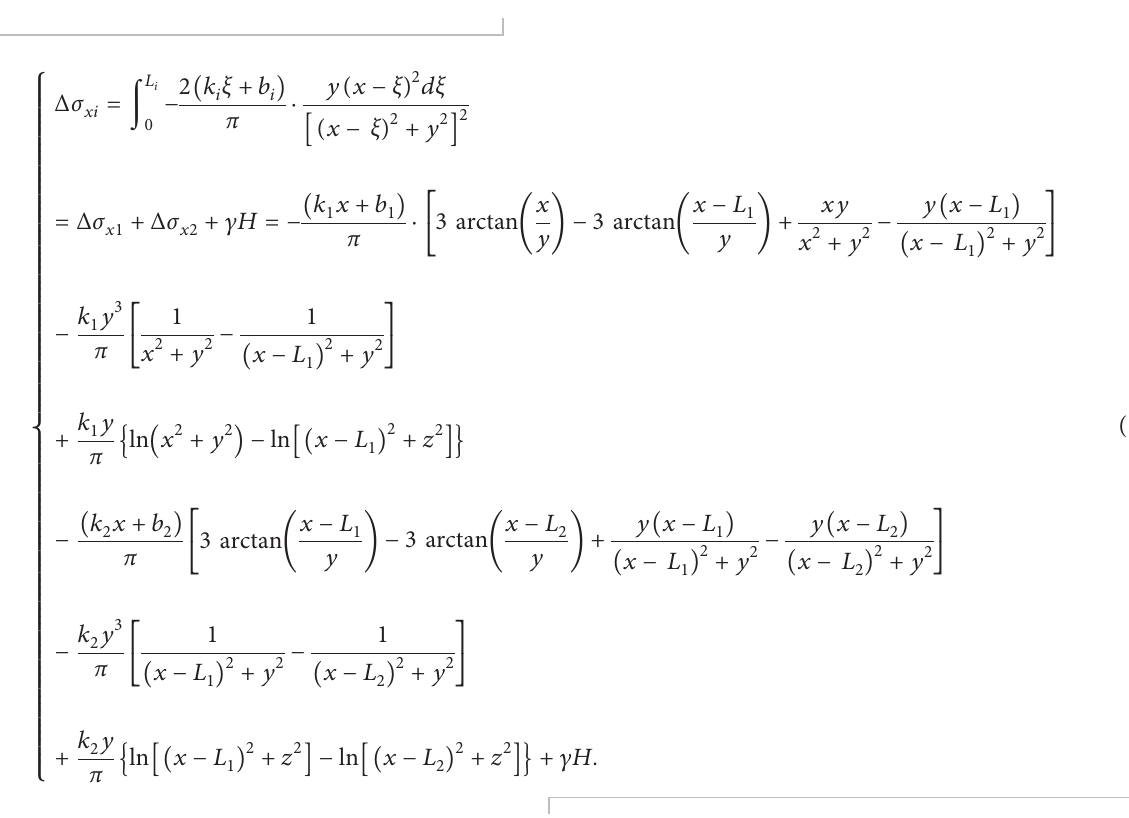
e . (b) The re- 1 , and U